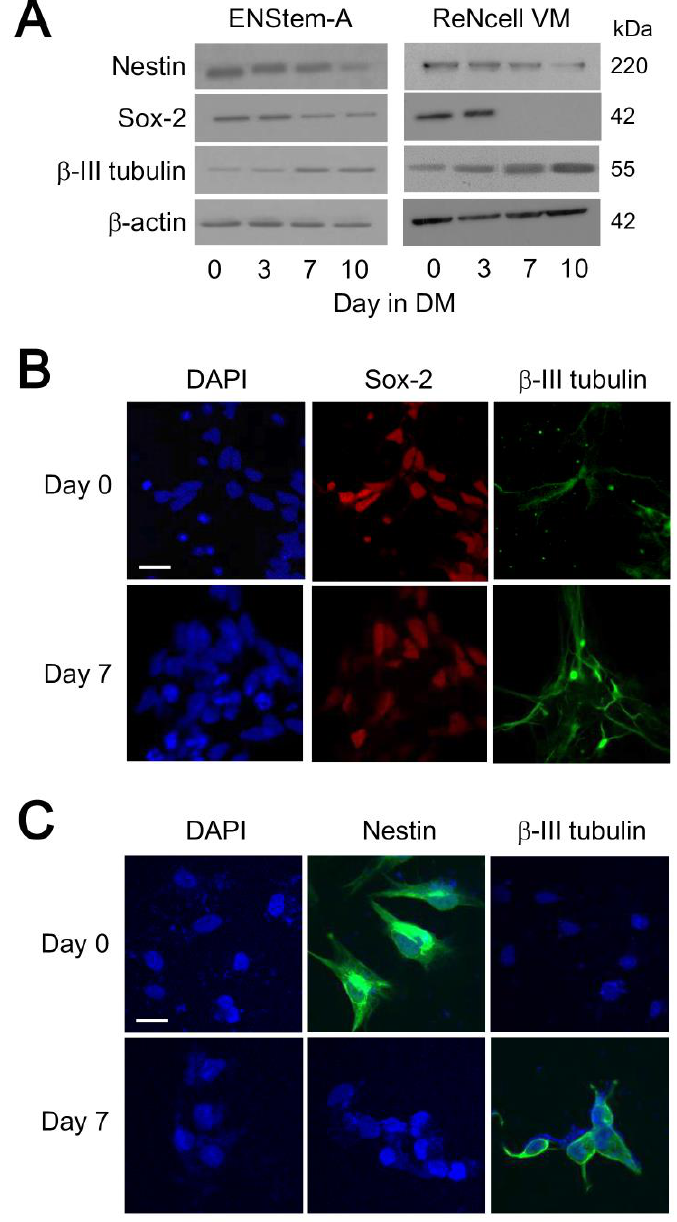
Figure 1. Di ff erentiation of human neural progenitor cells. ( A ) ENStem-A cells were induced to undergo di ff erentiation at passage number 6 while ReNcell VM cells were induced at passage number 9. Cell lysates were collected at Day 0, Day 3, Day 7 and Day 10 of di ff erentiation and subjected to Western blot analysis using anti-Nestin, anti-Sox-2, anti- β -III tubulin and anti- β -actin antisera. Data shown represent one of three or more sets of immunoblots; other sets yielded similar results. ( B ) ENStem-A cells were fixed by 4% paraformaldehyde at Day 0 and Day 7 of di ff erentiation. Cell nuclei were stained with DAPI (4’,6-diamidino-2-phenylindole) while Sox-2 and, β -III tubulin were identified by specific antisera and fluorescent secondary antibodies. Images were obtained with a Zeiss LSM700 confocal microscope. ( C ) ReNcell VM cells were processed as in B except anti-nestin was used instead of anti-Sox-2 for assessing pluripotency. Scale bar indicates 10 μm.